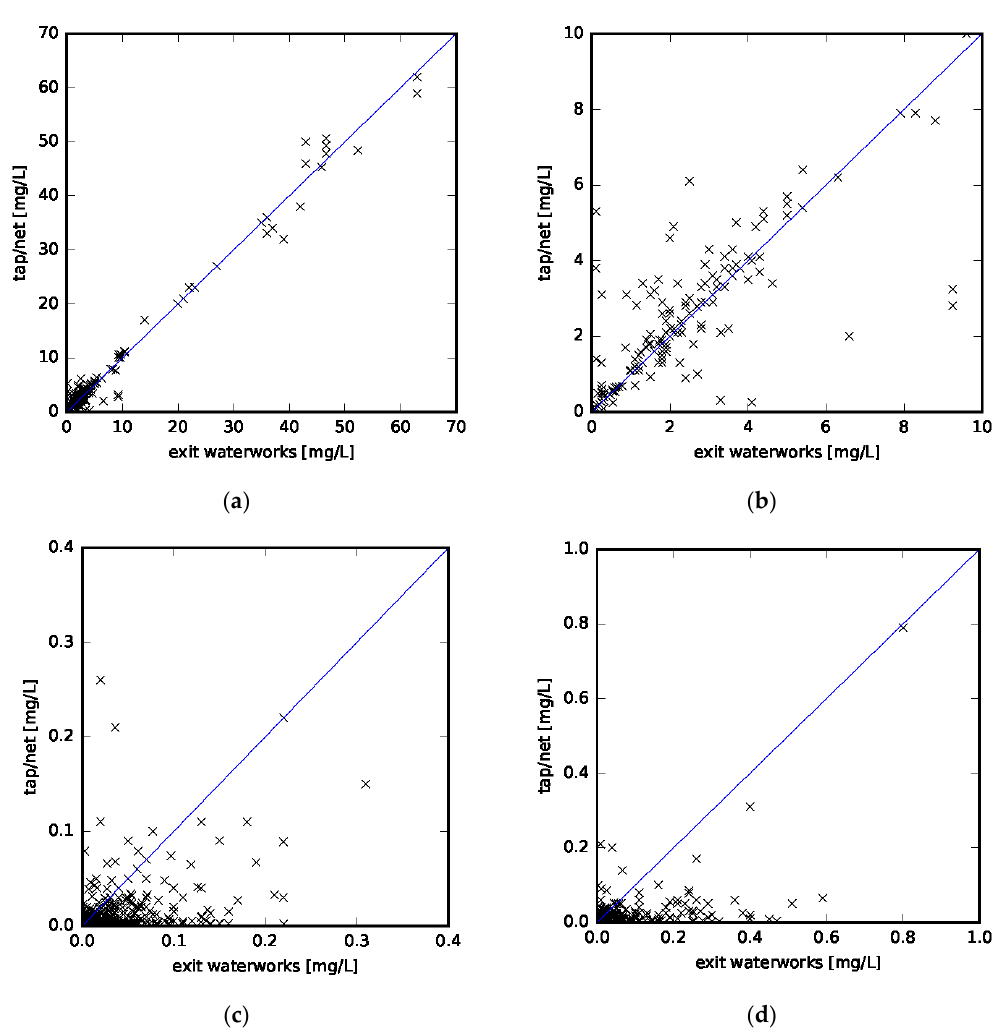
Figure 4. Concentrations at the waterworks versus concentrations in the distribution system or at the consumers’ taps for ( a ) Nitrate ( N = 195); ( b ) Nitrate zoomed below 10 mg/L; ( c ) Nitrite ( N = 1562); ( d ) Ammonium ( N = 391). The blue line indicates the identity line.